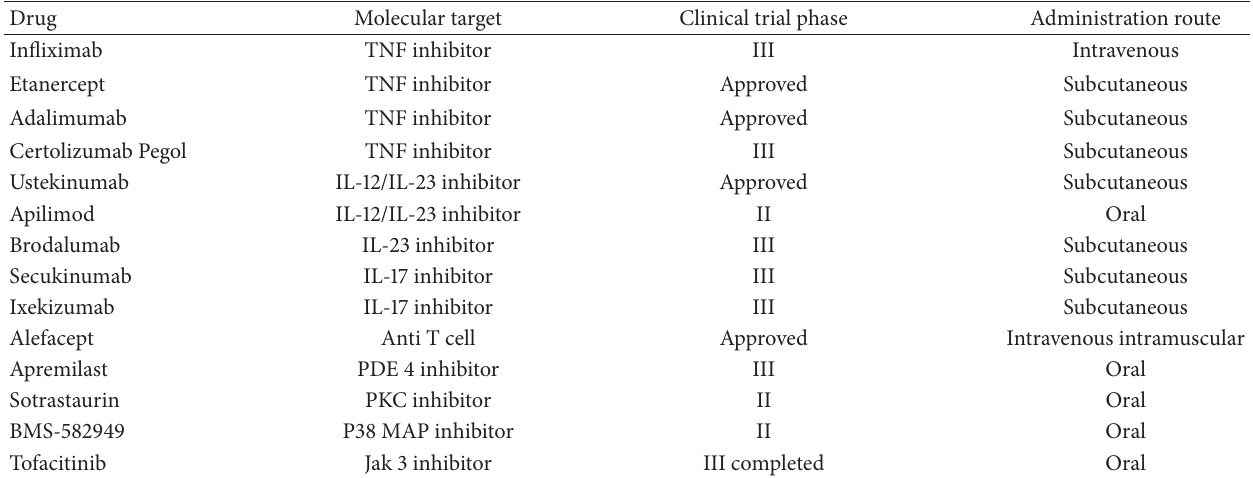
Table 1: Drugs involved in the treatment of